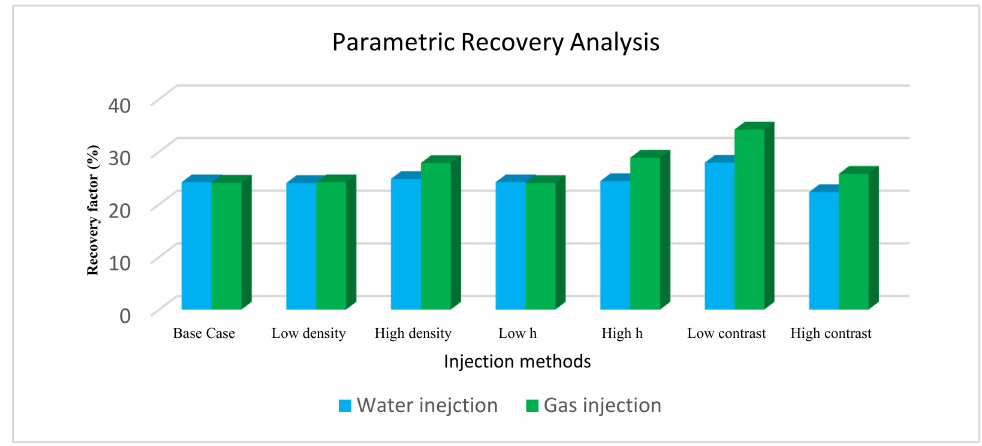
Figure 16. Effect of different parameters of oil recovery for water (blue) and gas injection (green).